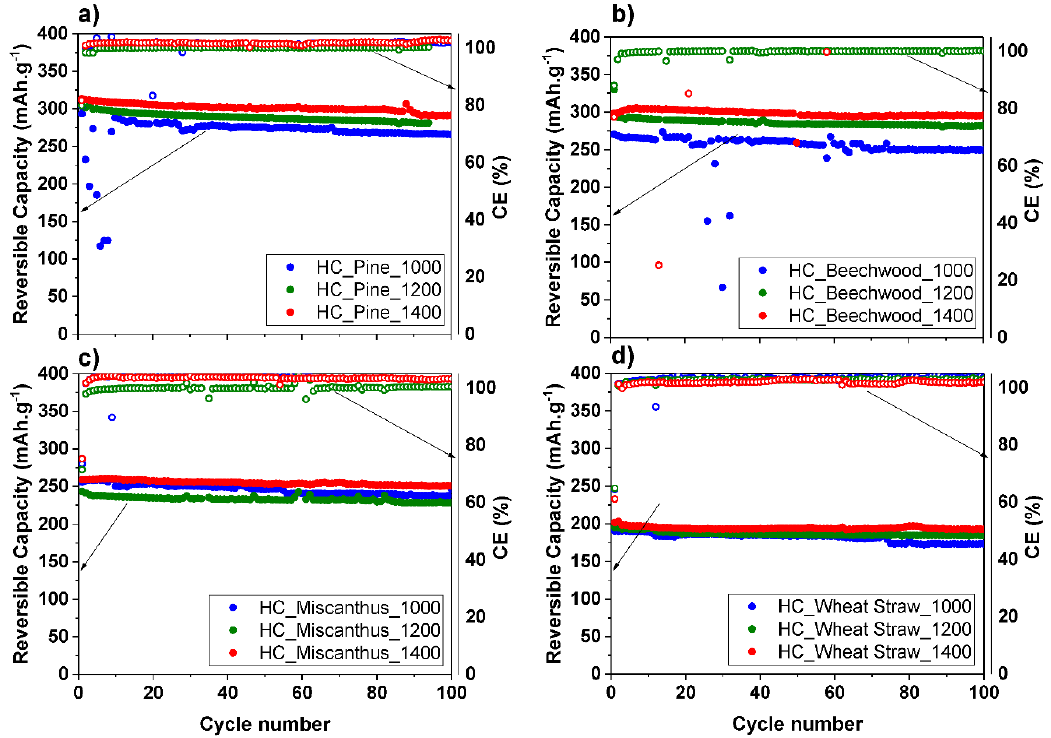
Figure 10. Stability of cycling for ( a ) pine, ( b ) beechwood, ( c ) miscanthus and ( d ) wheat straw derived hard carbons at C/10.